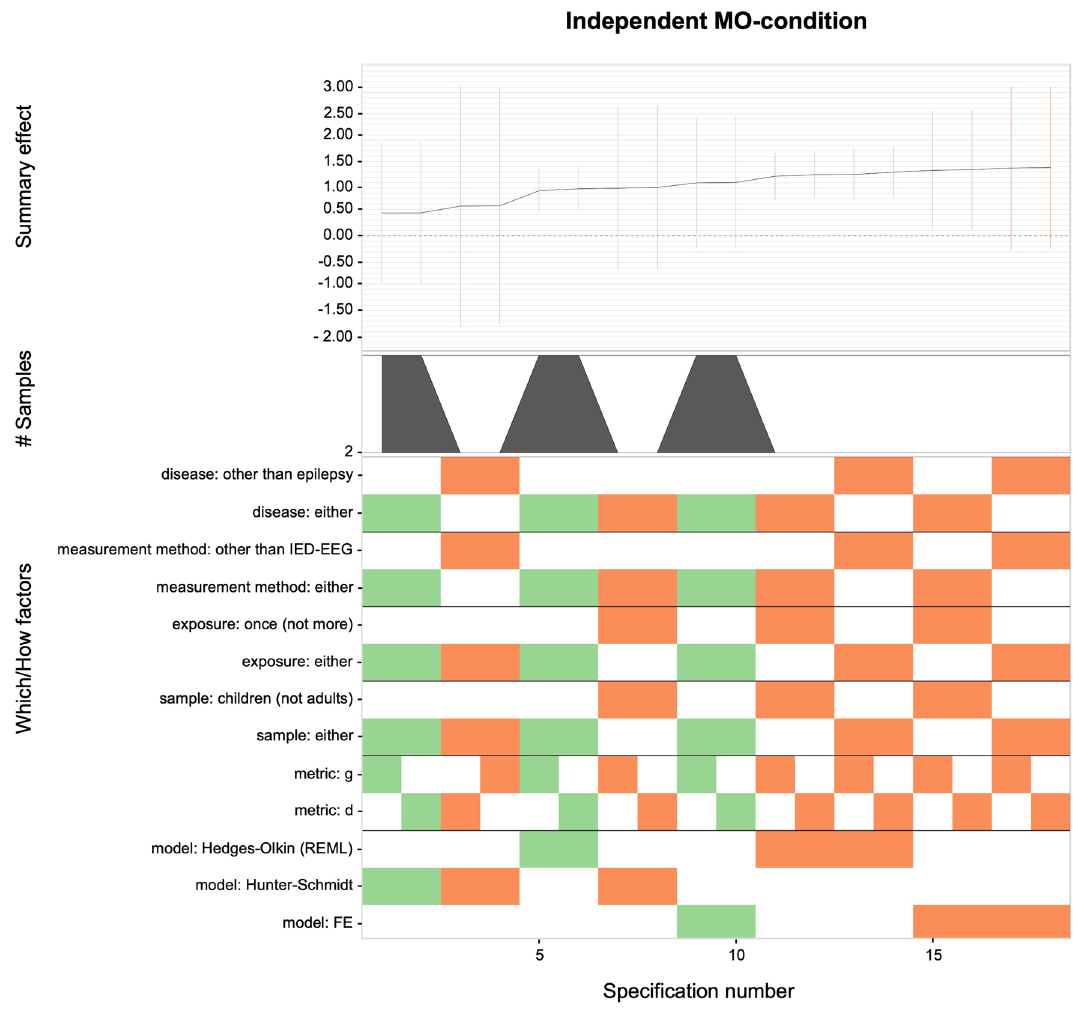
Figure 4. Descriptive meta-analytic specification plot of summary effects from all reasonable specifications for the independent MO-condition. The independent MO-condition includes studies with pretest–posttest designs of independent groups examining exposure to KV448 versus silence 11,27,28 . The bottom panel indicates the “ which ” and “ how ” factors that were included (warmer vs. cooler spectral colors are indicative of lower vs. higher presision of estimates) for the estimated summary effects depicted in the top panel with respective 95% confidence intervals. The center panel indicates the number of samples within the respective